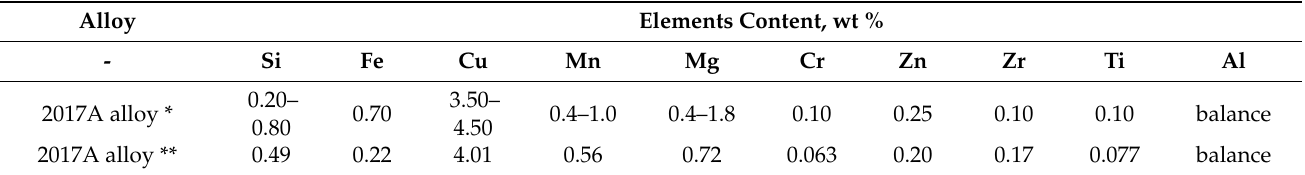
Table 2. Chemical composition of the 2017A aluminium alloy, weight %. Alloy